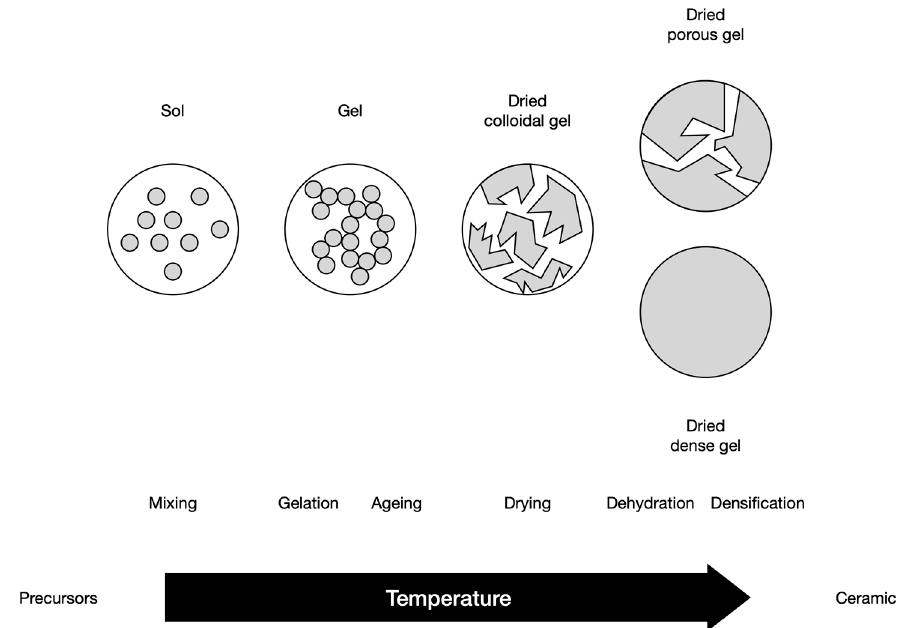
Figure 1. Schematic representation of the gel evolution during the sol–gel